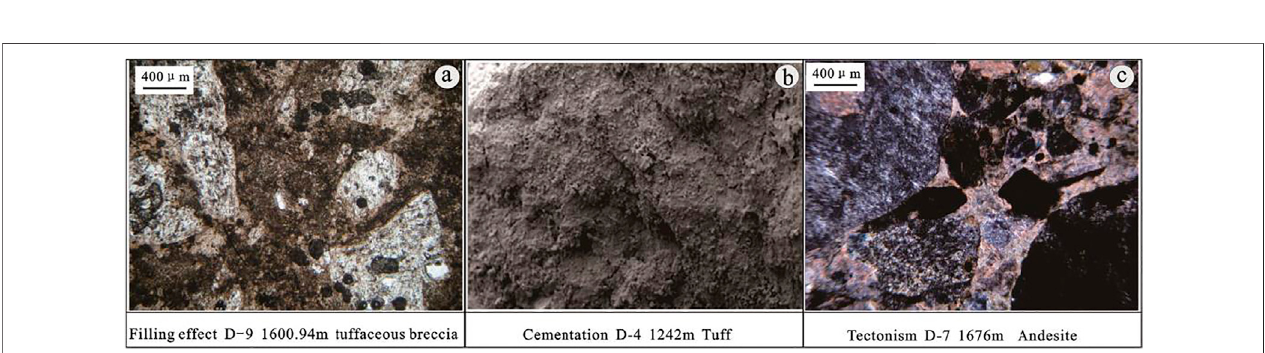
FIGURE 12 | Diagenesis and porosity evolution of volcanic reservoir in the D oil fi eld of the Laizhouwan sag.